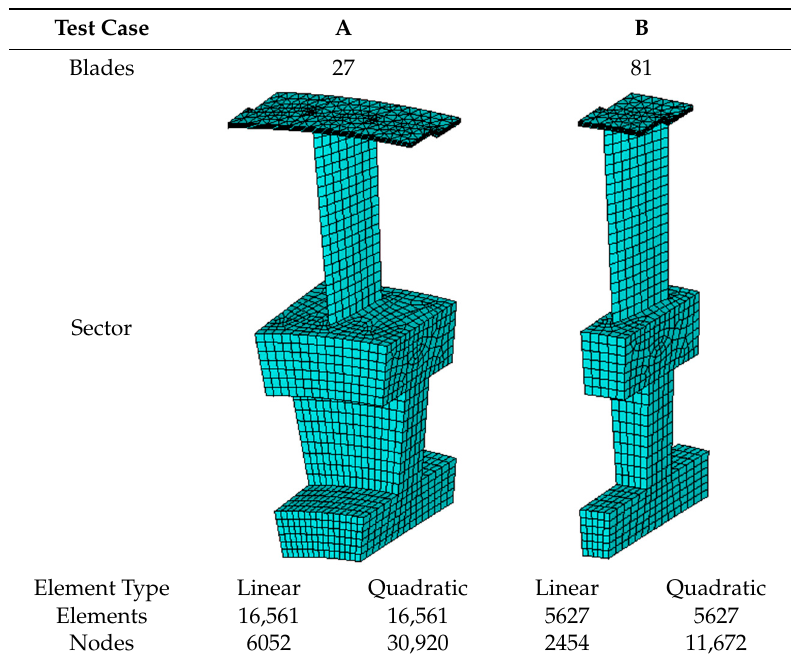
Table 1. Details of the numerical test case.